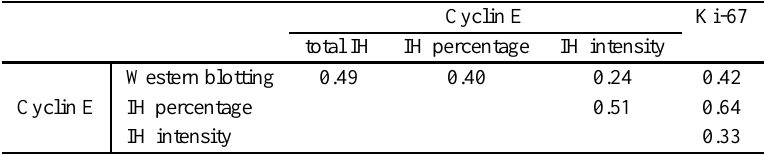
Correlation coefficients ( r 2 -values) for cyclin E protein expression and tumour prolif- eration as measured by Ki-67 index in breast cancer specimens